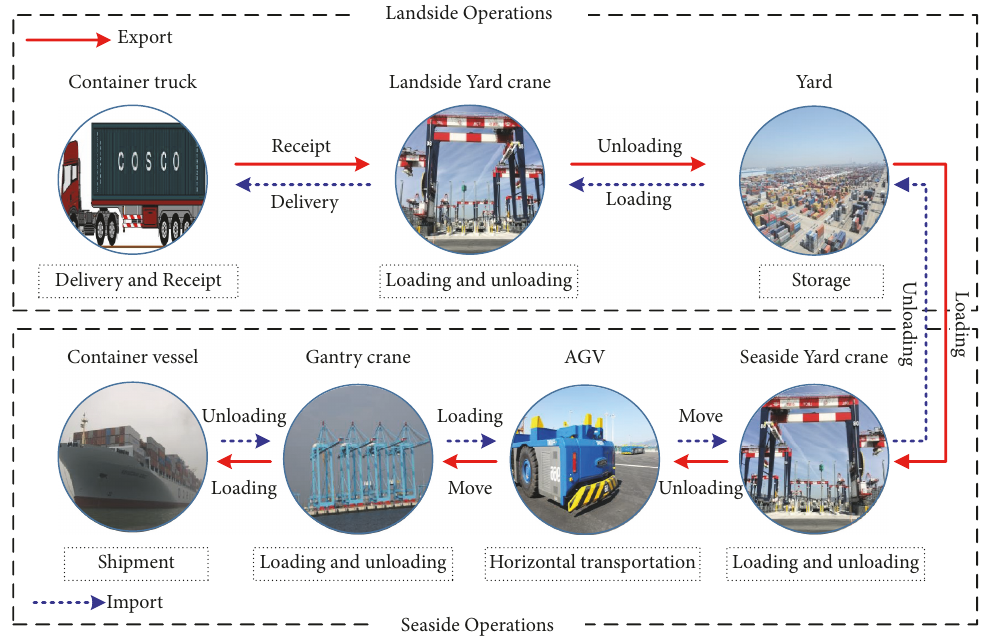
Figure 1: General model of container handling operations in automated container